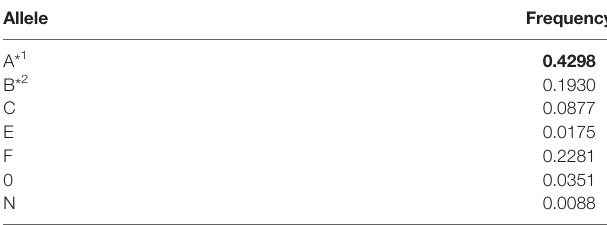
TABLE 1 | CSN1S1 allelic frequencies in the Garganica goat population.